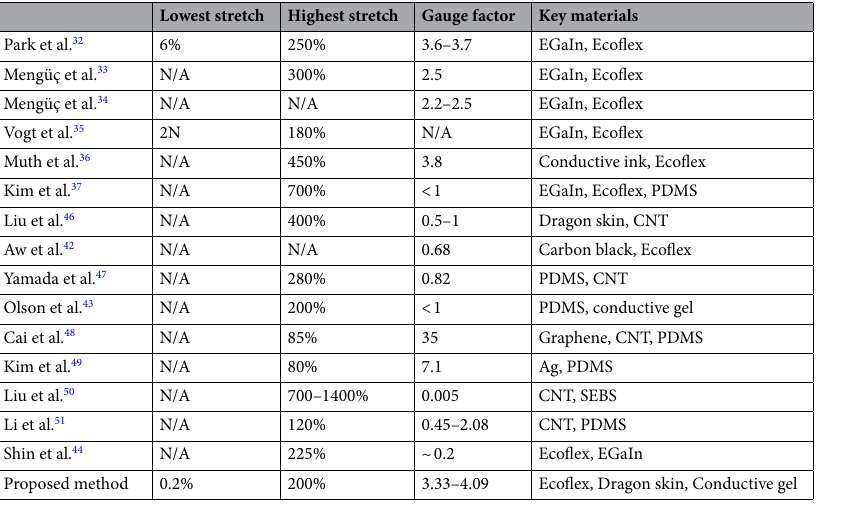
Table 3. Comparison the performance of the proposed soft sensor with the soft sensors in the